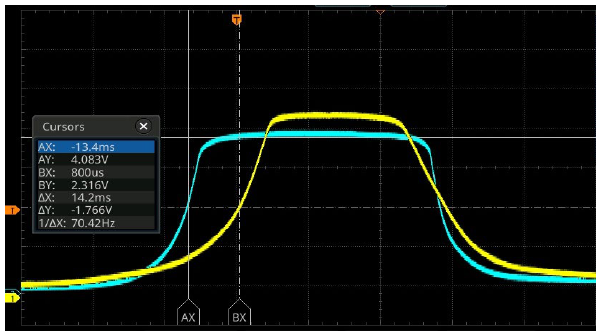
Fig. 4. Time delay between synchronisation signals: end switch signal from stator (yellow), end switch signal from rotor